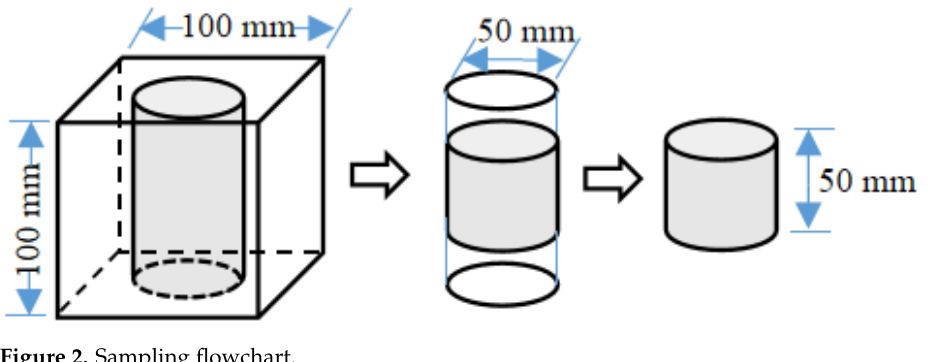
Figure 2. Sampling